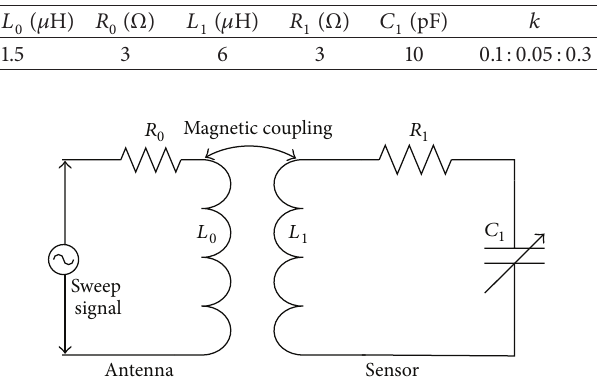
Figure 1: Schematic diagram of the single-parameter LC resonant sensor system.